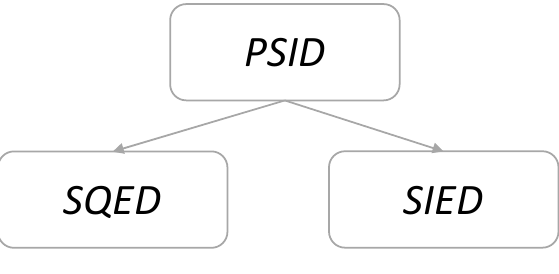
Figure 4. Divergent relationship